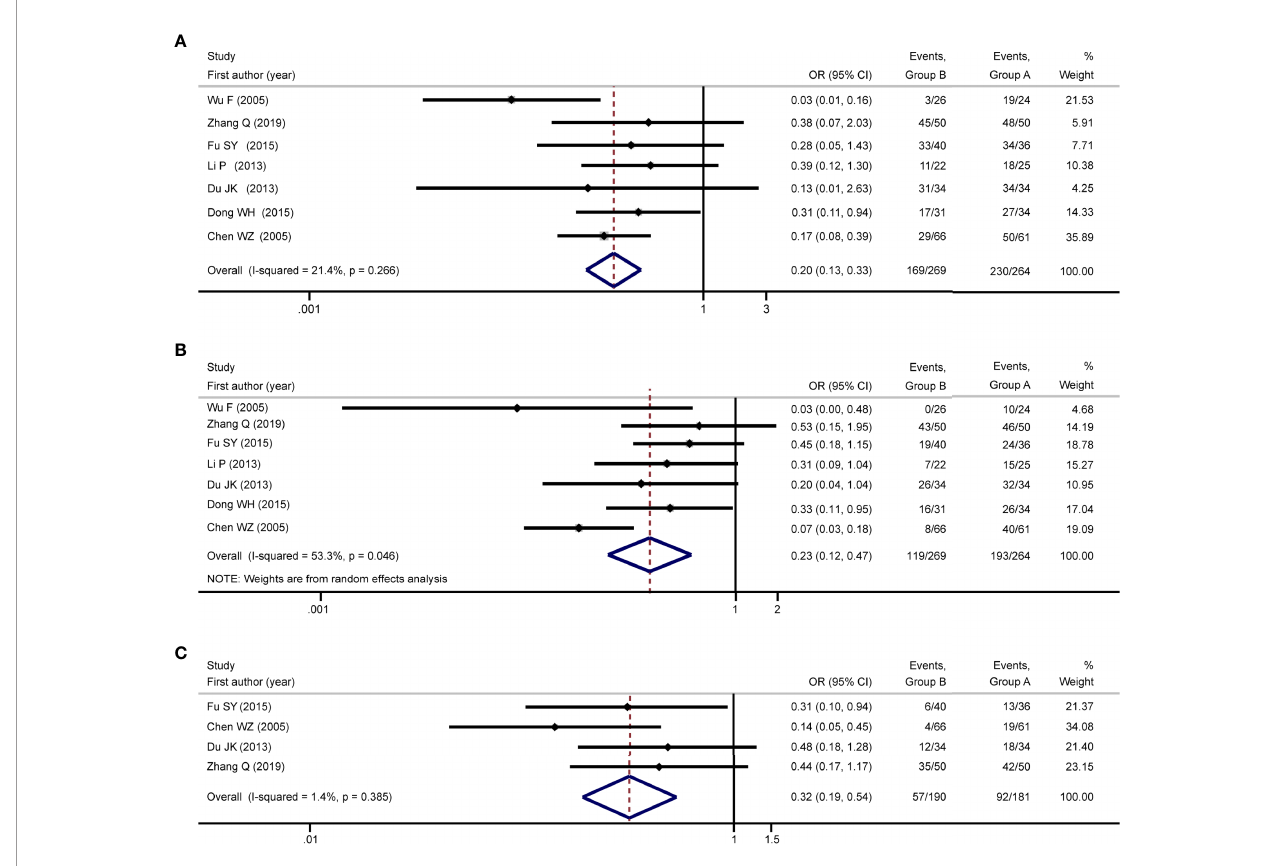
FIGURE 2 | Meta-analysis of overall survival. Meta-analysis of overall survival was conducted with the outcomes of 6-month OS rate, 12-month OS rate, and 24- month OS rate, respectively. Results of the meta-analyses showed that group A was associated with increased 6-month OS rate [OR: 0.20; 95% CI: 0.13-0.33; (A) ], 12-month OS rate [OR: 0.23; 95% CI: 0.12-0.47; (B) ], and 24-month OS rate [OR: 0.32; 95% CI: 0.19-0.54; (C) ] compared to group B, and no high statistical heterogeneities were detected. Group A: TACE in combination with HIFU; Group B: TACE alone; TACE, transcatheter arterial chemoembolization; HIFU, high- intensity focused ultrasound; OS, overall survival; OR, odds ratio; CI, con fi dence